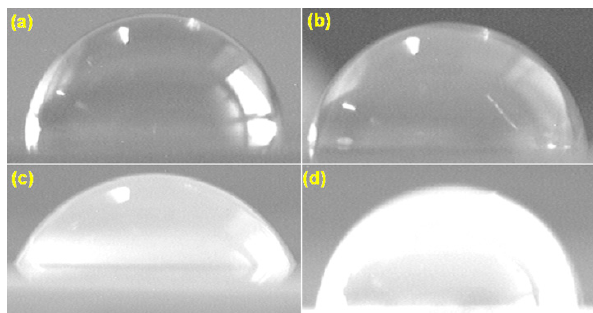
Figure 4. Contact angle images of the synthesized LDHs. ( a ) S–NiMgAl–Mn, ( b ) S–NiMgAl–Co, ( c )